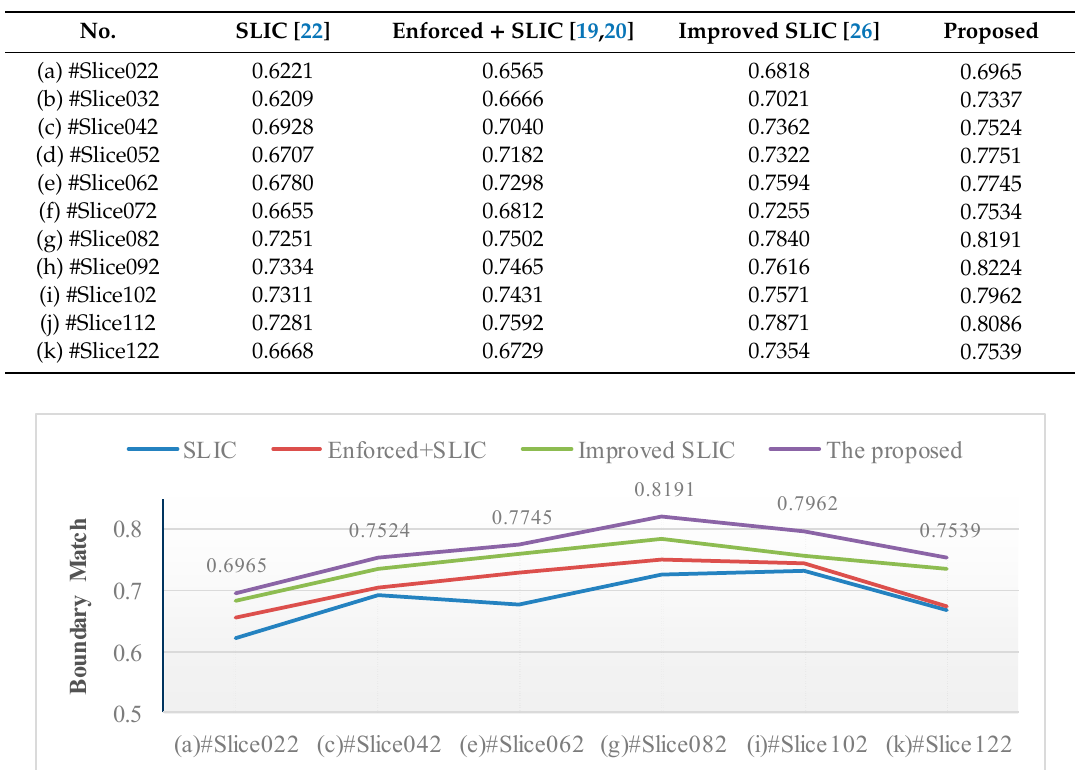
Table 2. The comparison of the boundary match of different algorithms.